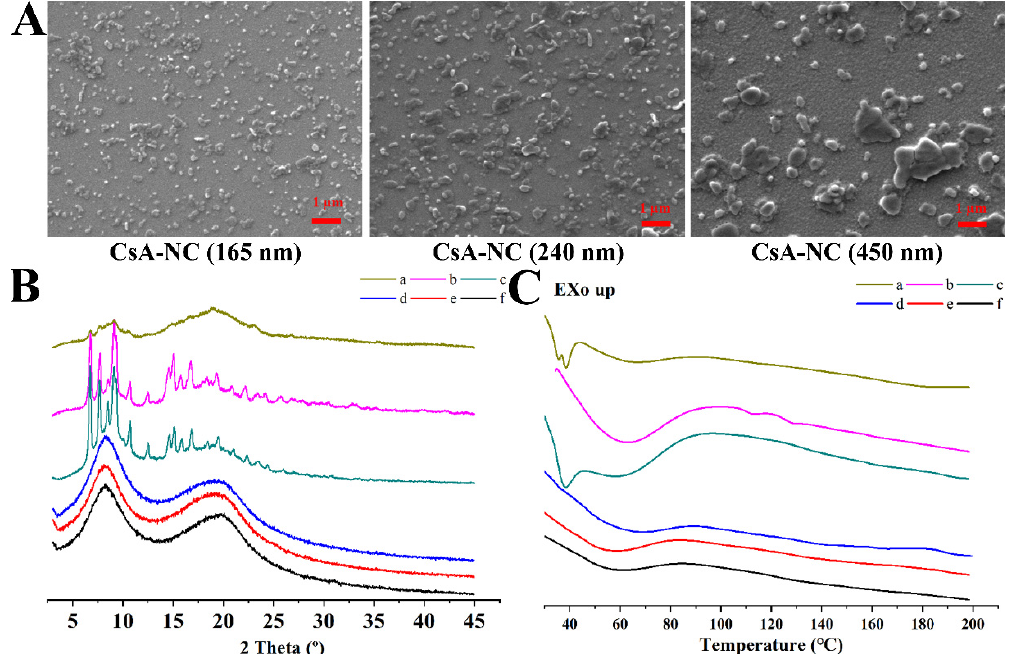
Figure 2. Physicochemical characterizations of various formulations. ( A ) SEM of various CsA-NCs; ( B ) XRD spectra; ( C ) DSC thermograms. (a) stabilizers; (b) free CsA; (c) physical mixture; (d) CsA-NC (450 nm); (e) CsA-NC (240 nm); (f) CsA-NC (165 nm).